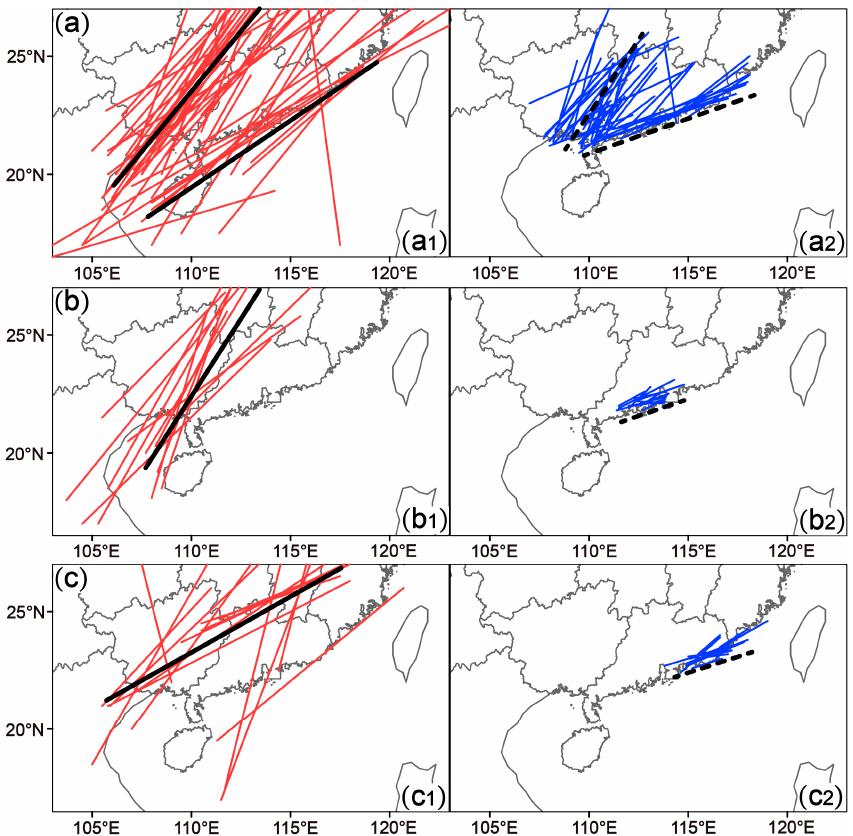
Figure 5. Distributions of ( a 1 , b 1 , c 1 ) 850-hPa low-level jet (LLJs) and ( a 2 , b 2 , c 2 ) OWSR axes with ( a , a 1 – a 2 ) a long and ( b , b 1 – b 2 ; c , c 1 – c 2 ) a short extension over South China in the SWLLJ situation. ( a 2 ) indicates the OWSRs located near the coastal areas of Guangxi Province and Guangdong Province, and ( b 2 ) and ( b 3 ) indicate the OWSRs located at west Guangdong Province and east Guangdong Province, respectively. The solid and dashed lines outline the primary orientations of LLJs and OWSR axes, respectively. The LLJ axis is defined as the axis of the 850-hPa wind speed zone larger than 8 m s − 1 . Atmosphere 2019 , 10 , x FOR PEER REVIEW